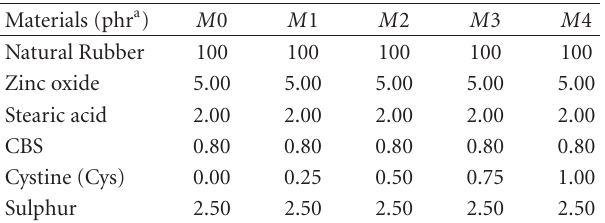
Table 1: Formulations for rubber